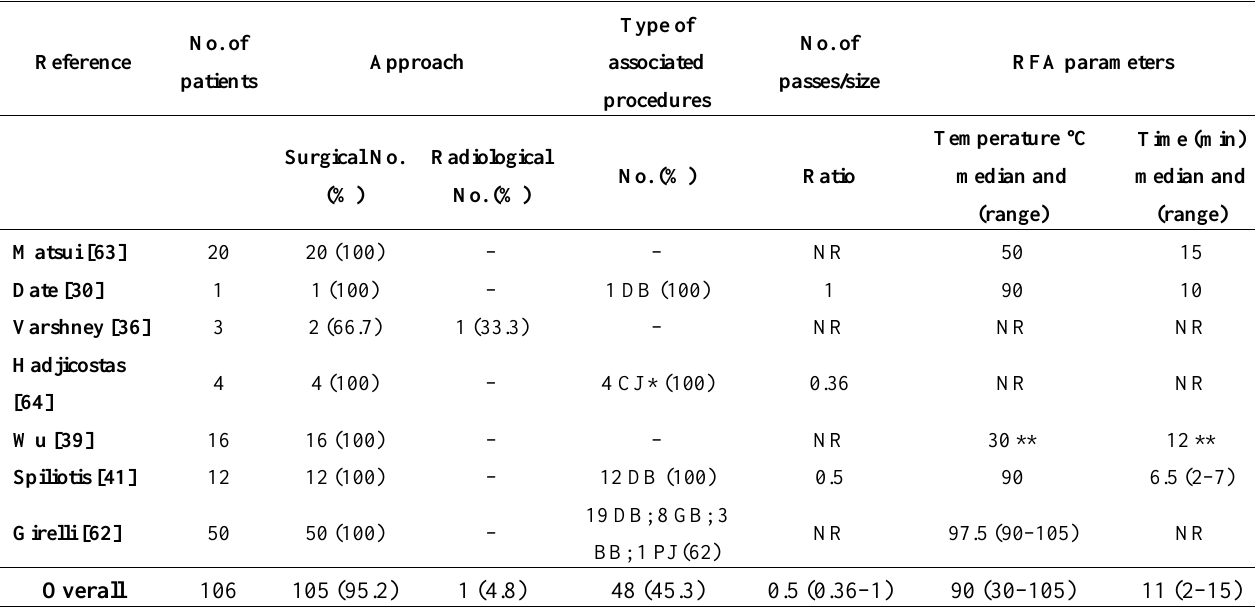
Table 2. Technical characteristics of radiofrequency ablation in the 106 patients. Data are reported as absolute number, frequency, median and range. DB: double bypass surgery (common bile duct-jejunostomy plus a gastrojejunostomy); CJ: cholecystojejunostomy; PJ: pancreaticojejunostomy. * the number of gastrojejunostomies not reported; ** the authors reported one minute at 90 °C. NR = not